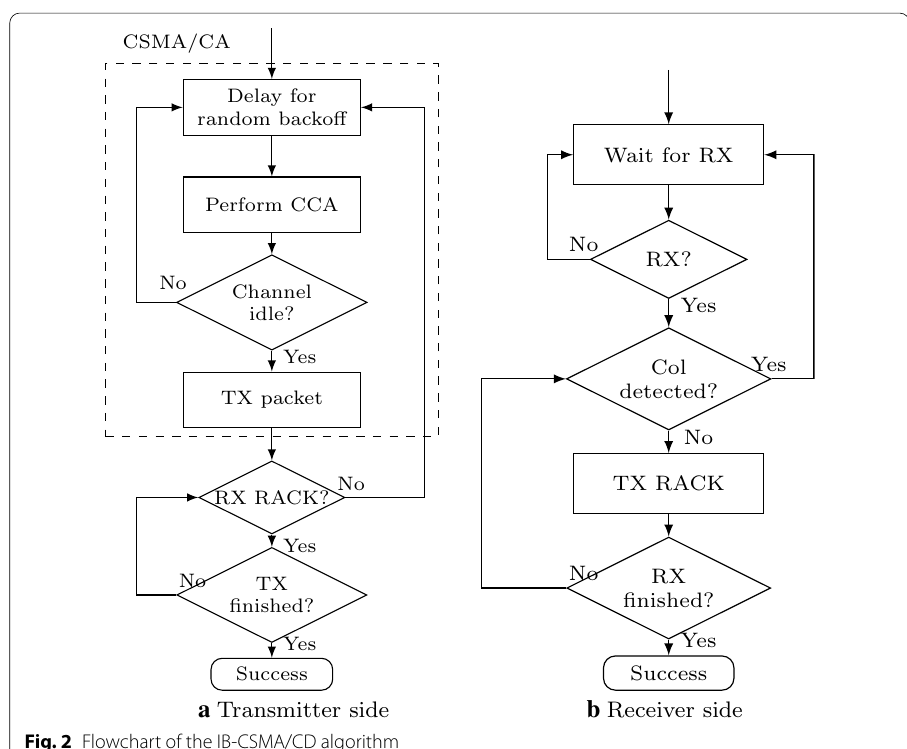
Fig. 2 Flowchart of the IB-CSMA/CD